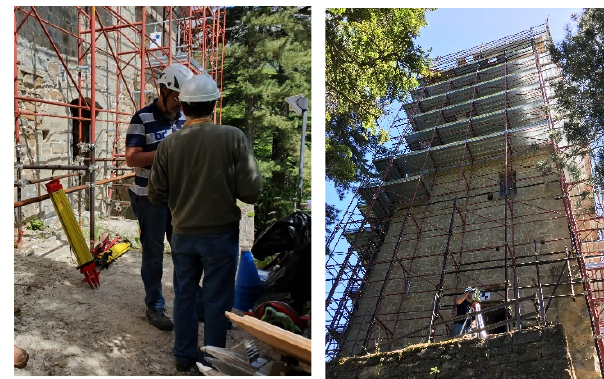
Figure 5. Survey campaign (May 2019)